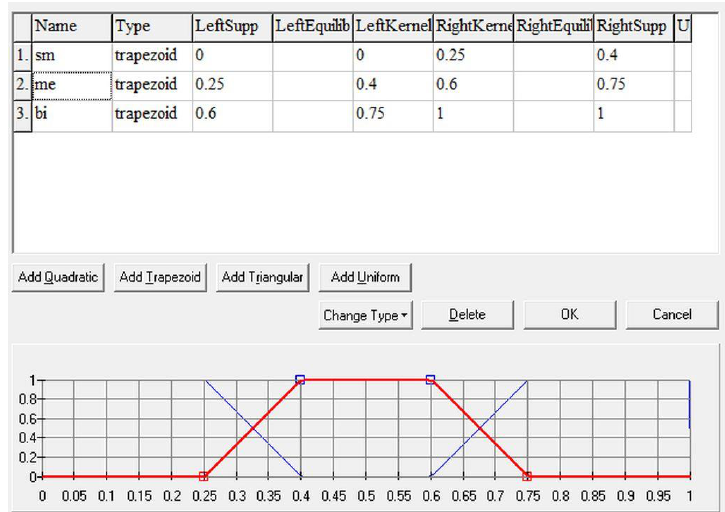
Figure 5. Graphic representation of the input value set V4.